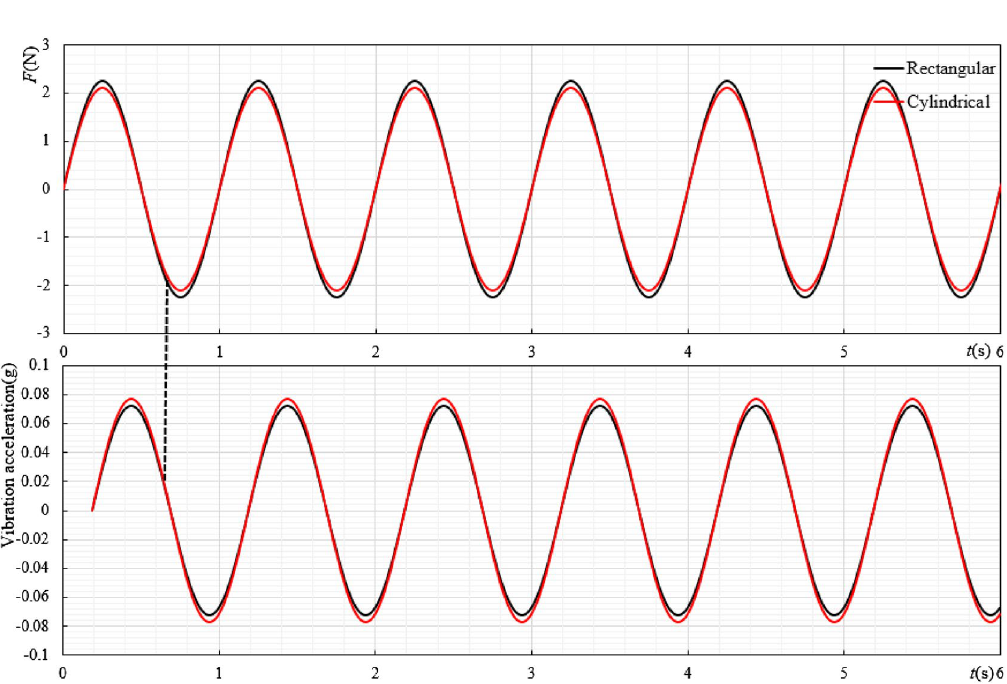
Figure 8. H = 0.15m , f = 1Hz , the water depth is 1.5 m, the variation law diagram of force and acceleration under different ore bin